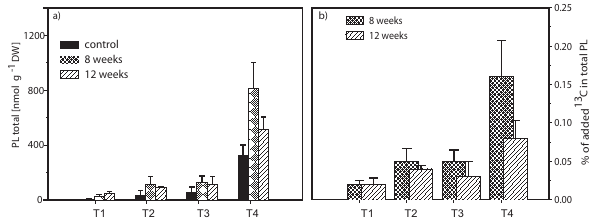
Fig. 1. Total phospholipid (PL) content (a) (nmolg − 1 DW) and per- centage of added 13 C incorporated into total PL (b) in soil sam- ples at different stages of ecosystem development T1–T4 in control samples and litter treatments (8 and 12 weeks) at individual litter harvesting time points (means + standard deviation, n =